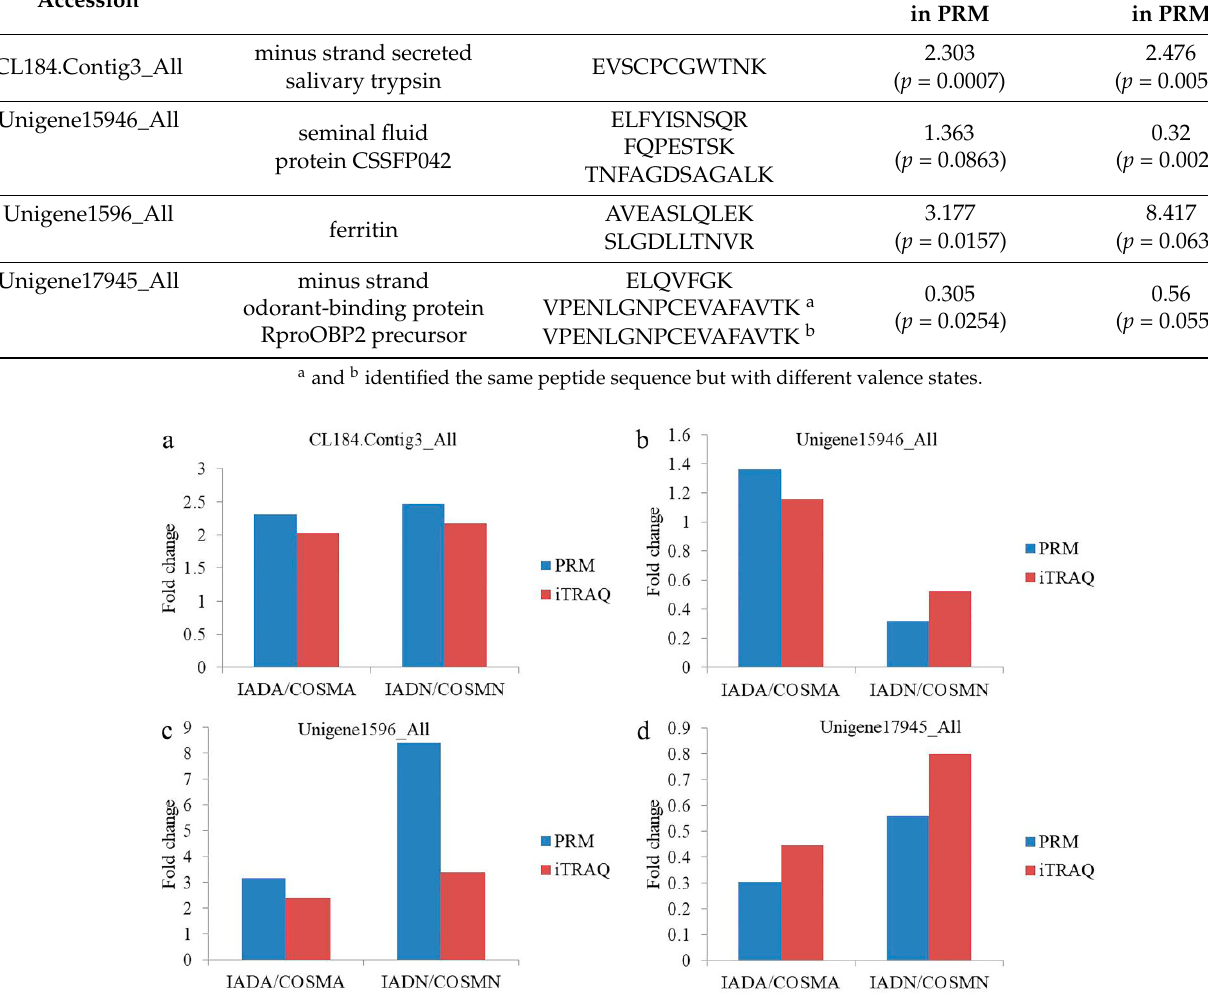
Figure 9. Relative expression levels of selected proteins obtained using iTRAQ and PRM in the IADA/COSMA and IADN/COSMN: ( a ) CL184.Contig3_All (minus strand secreted salivary trypsin); ( b ) Unigene15946_All (seminal fluid protein CSSFP042); ( c ) Unigene1596_All (ferritin); ( d ) Unigene17945_All (minus strand odorant-binding protein RproOBP2 precursor).